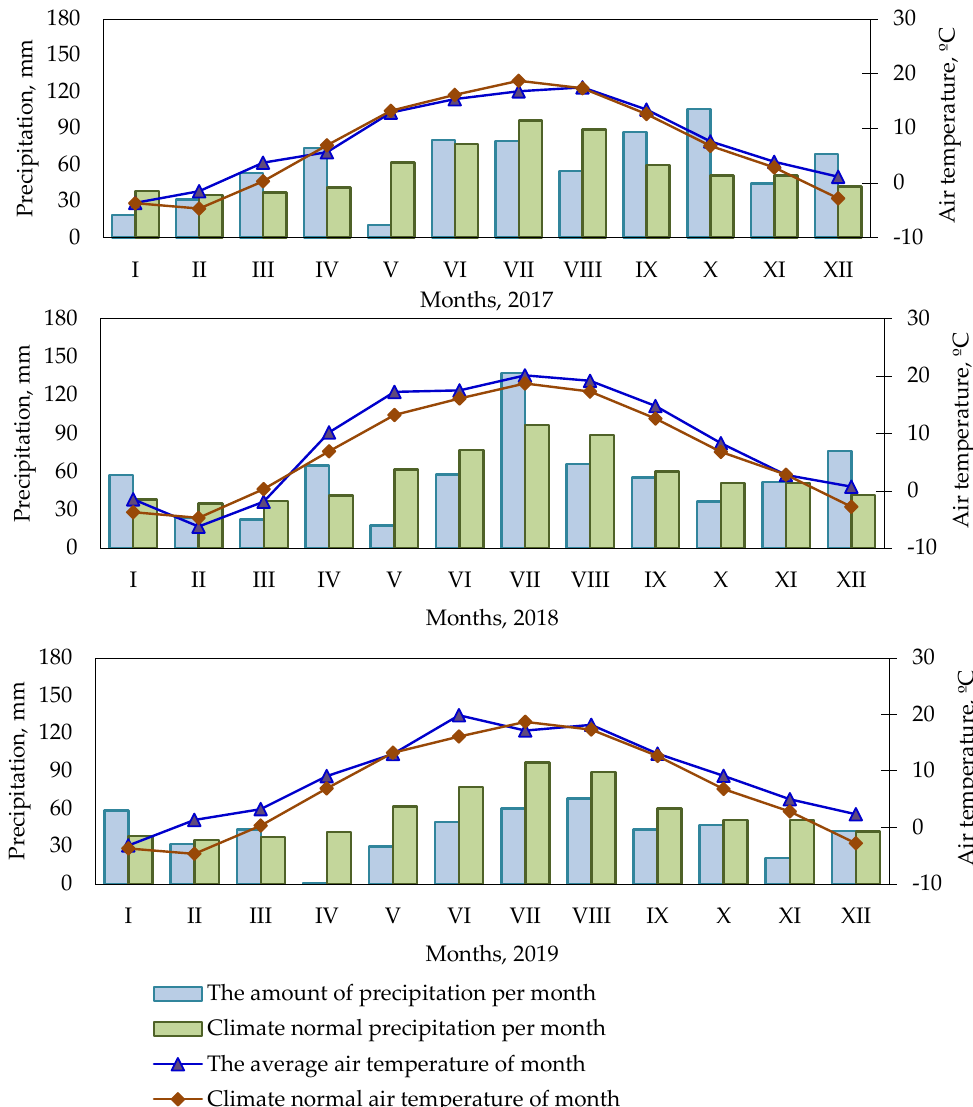
Figure 3. Meteorological conditions during the experimental period, Kaunas Weather Station. Note: Climate normal = The average data for 40 years (1974–2013).